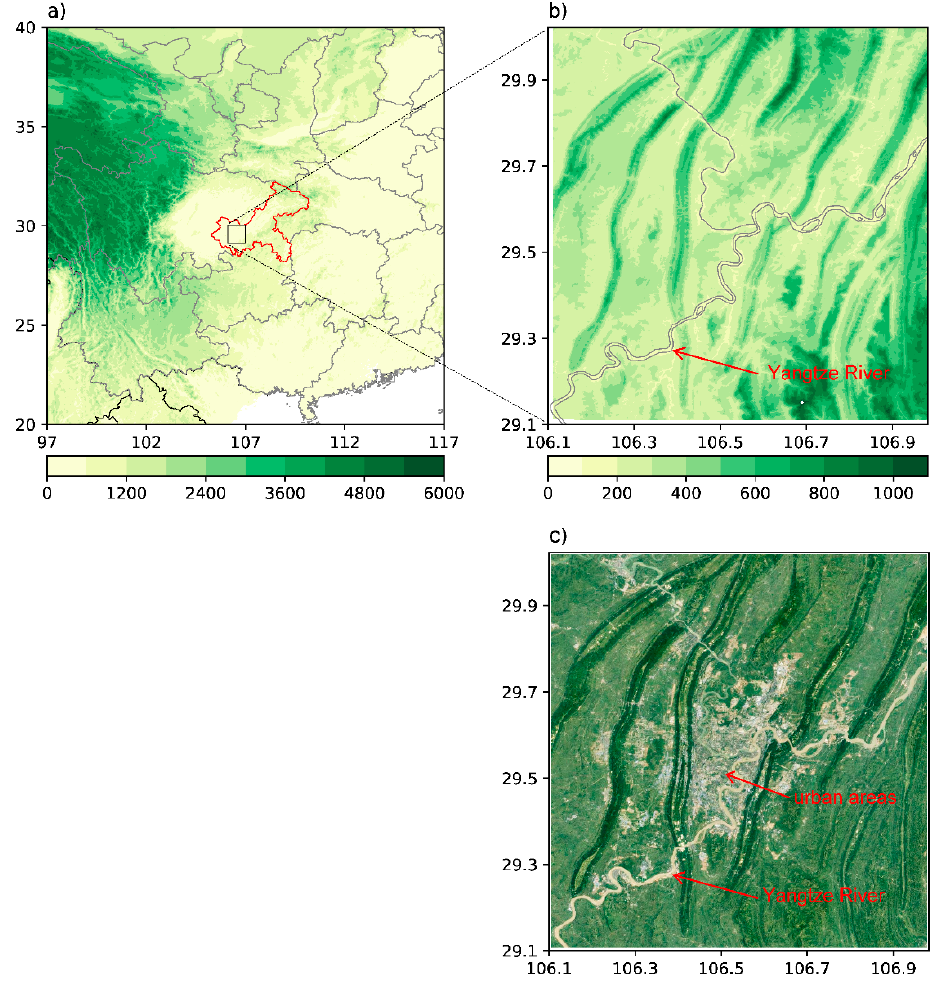
Figure 1. Locations of ( a ) Chongqing Municipality (red curve) and ( b ) central urban area of Chongqing City. Shades in ( a ) and ( b ) are topography (m). ( c ) The corresponding satellite image of ( b ). Gray patches and dark green belt-like shapes in ( c ) denote urban areas and folding mountains, respectively.